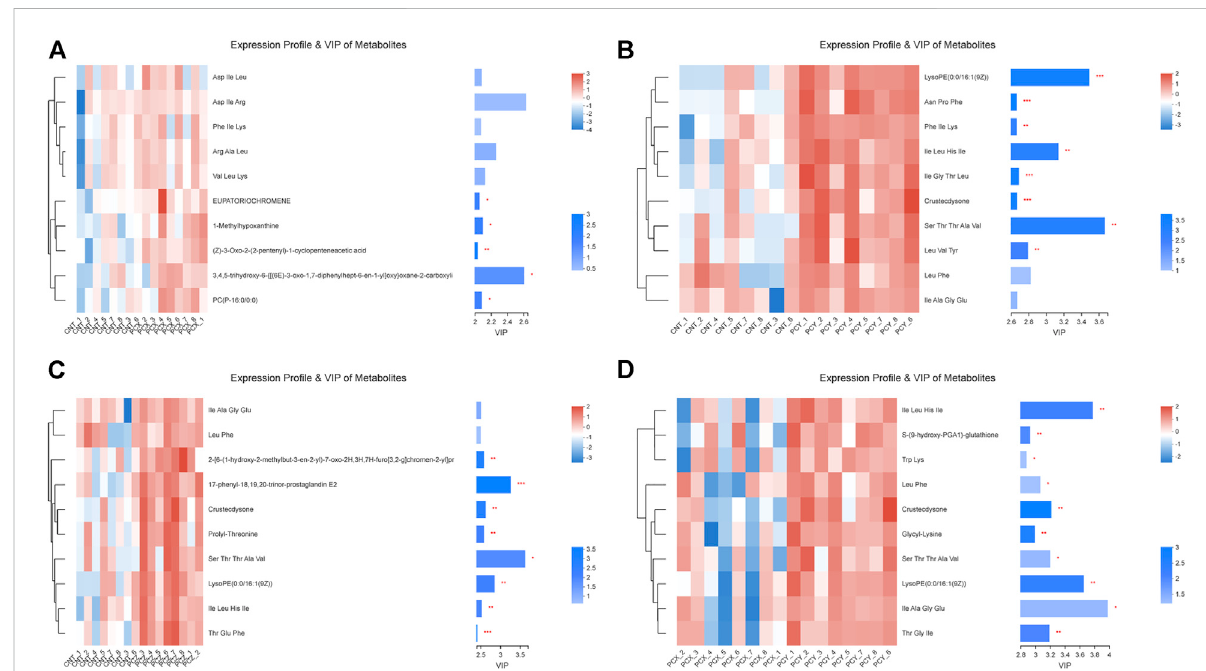
FIGURE 5 (A) Expression pro fi le and VIP of metabolites between the PCX and CNT groups. (B) Expression pro fi le and VIP of metabolites between the PCY and CNT groups. (C) Expression pro fi le and VIP of metabolites between the PCZ and CNT groups. (D) Expression pro fi le and VIP of metabolites between the PCX and PCY groups. Differences were considered statistically signi fi cant at * p < 0.05; ** p < 0.01; *** p < 0.001